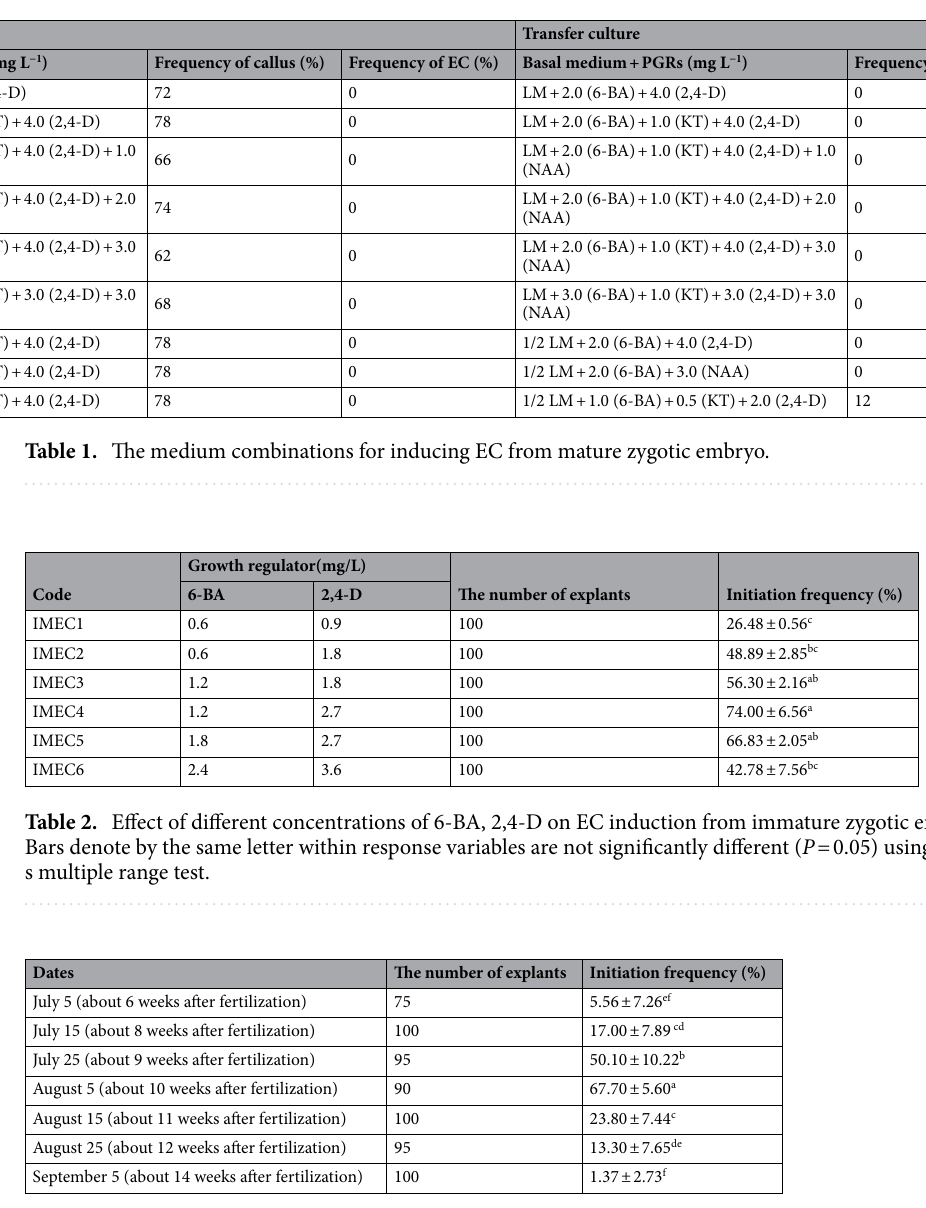
Table 3. Effect of collection dates on EC initiation. Bars denote by the same letter within response variables are not significantly different ( P = 0.05) using Duncan’ s multiple range test.